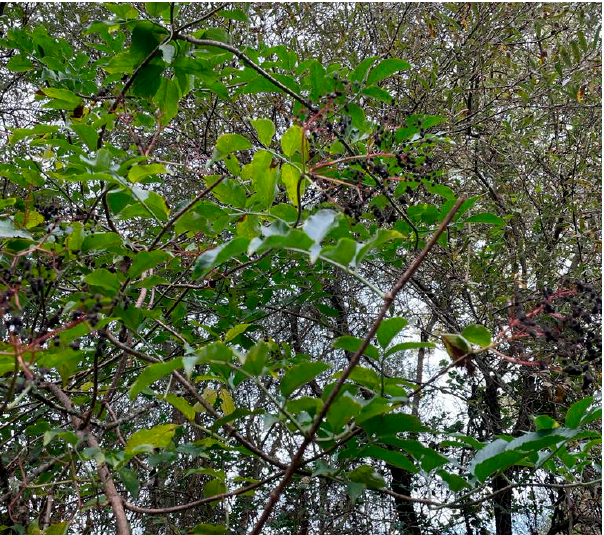
Figure 1. Elderberry tree with the ripe fruit used to obtain the extract.